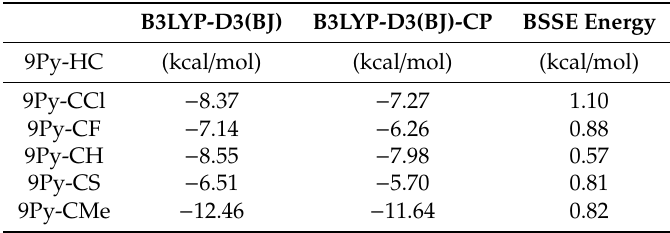
Table 4. Complexation energies for 9Py-HC complexes (HC = CCl, CF, CH, CS, and CMe) at the